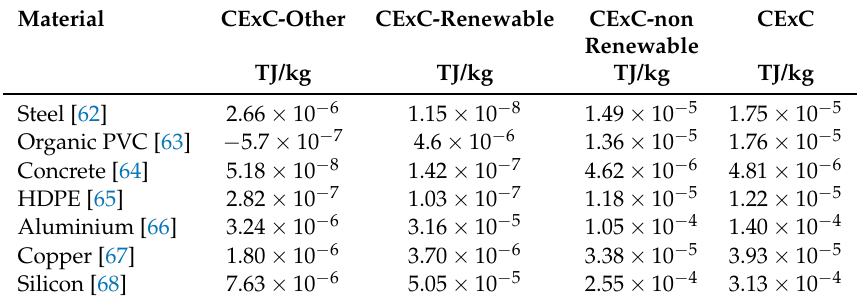
Table A6. CExC-factors of the used materials of the considered conversion units and storages.